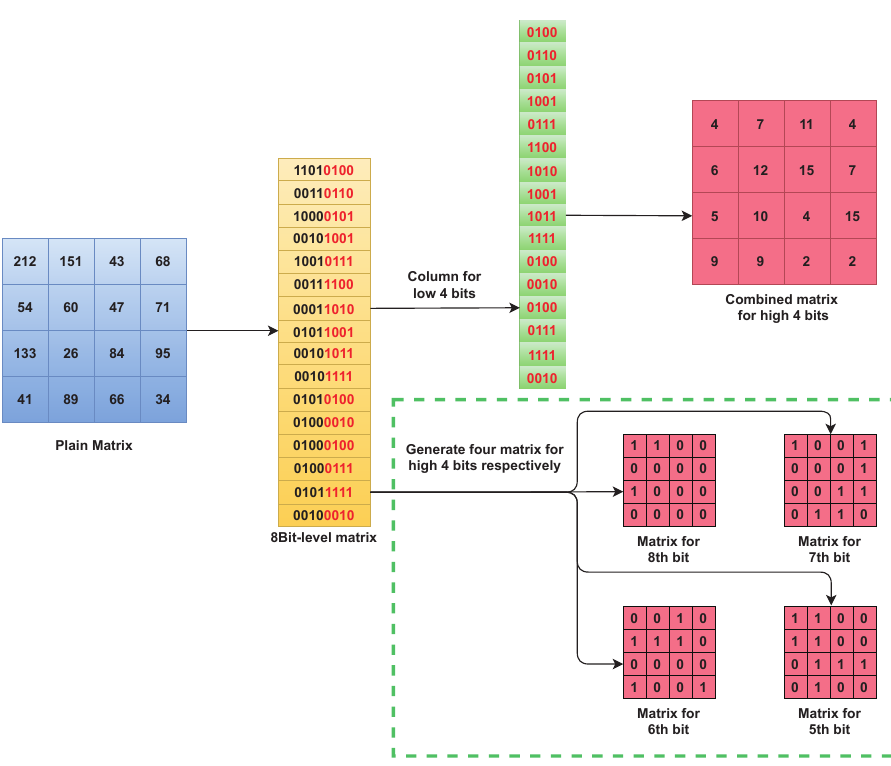
Figure 5. The conversion of the plaintext